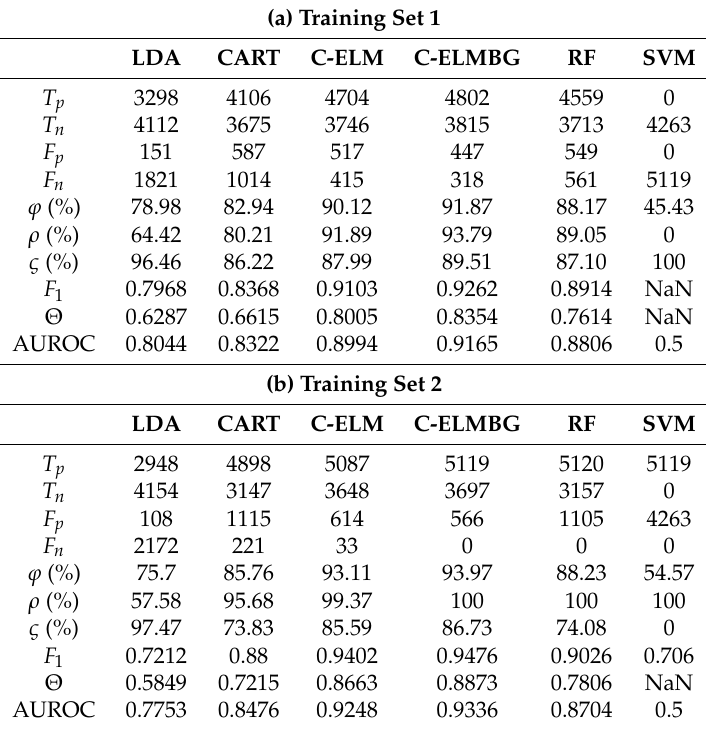
Table 4. Results of the test